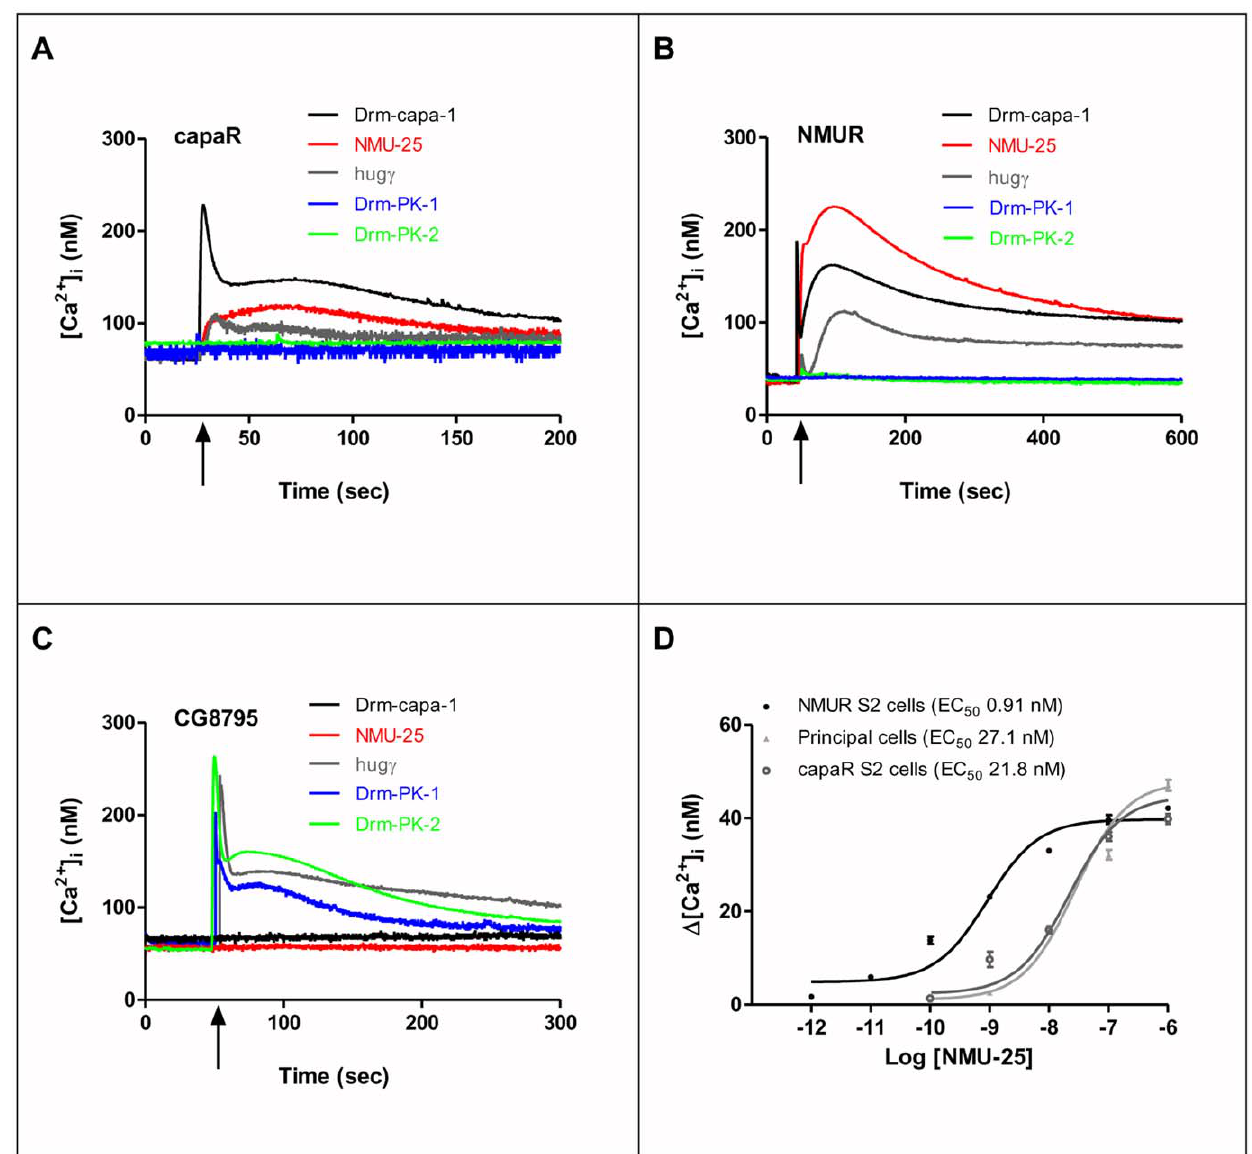
Figure 3. Capa, Neuromedin and Hugin receptor (CG8795) -associated calcium signatures. ( A ) Typical cytoplasmic Ca 2 + response in S2 cells expressing capaR and apoaequorin challenged with Drm-capa-1, Drm-PK-1, hugg, Drm-PK-2 and NMU-25 at a concentration of 10 2 7 M. ( B ) Typical cytoplasmic Ca 2 + response in S2 cells expressing NMUR 2 and apoaequorin challenged with Drm-capa-1, Drm-PK-1, hugg, Drm-PK-2 and NMU-25 at a concentration of 10 2 7 M. ( C ) Typical cytoplasmic Ca 2 + response in S2 cells expressing CG8795 and apoaequorin challenged with Drm-capa-1, Drm-PK- 1, hugg, Drm-PK-2 and NMU-25 at a concentration of 10 2 7 M. ( D ) Human NMU-25 dose-response curve in S2 cells and intact tubule. NMU-25 peptide stimulation of NMUR 2- or capaR- and apoaequorin-co-transfected S2 cells; and of tubule principal cells expressing apoaequorin transgene. Cells or tubules were challenged with increasing concentrations of agonist, and [Ca 2 + ] i was measured. Values were expressed as maximal (nM) - background (nM) (mean 6 S.E.M., N